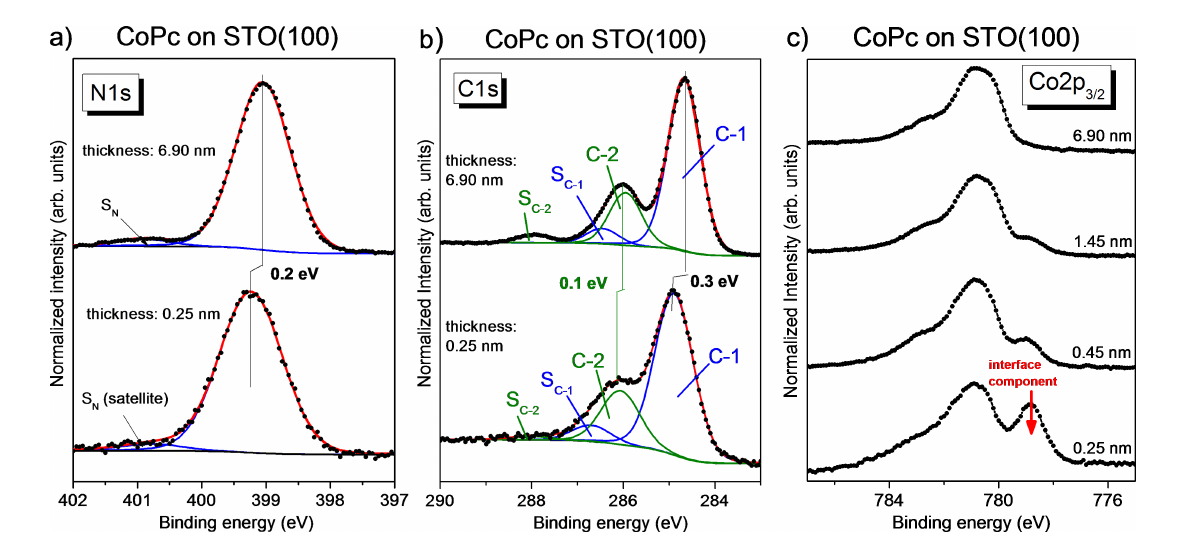
Figure 3: CoPc on STO(100). (a) N 1s, (b) C 1s, and (c) Co 2p core level spectra for a multilayer film compared to a coverage of a monolayer. The Co 2p spectra show clearly an interface component at lower binding energy than the main component (see arrow).